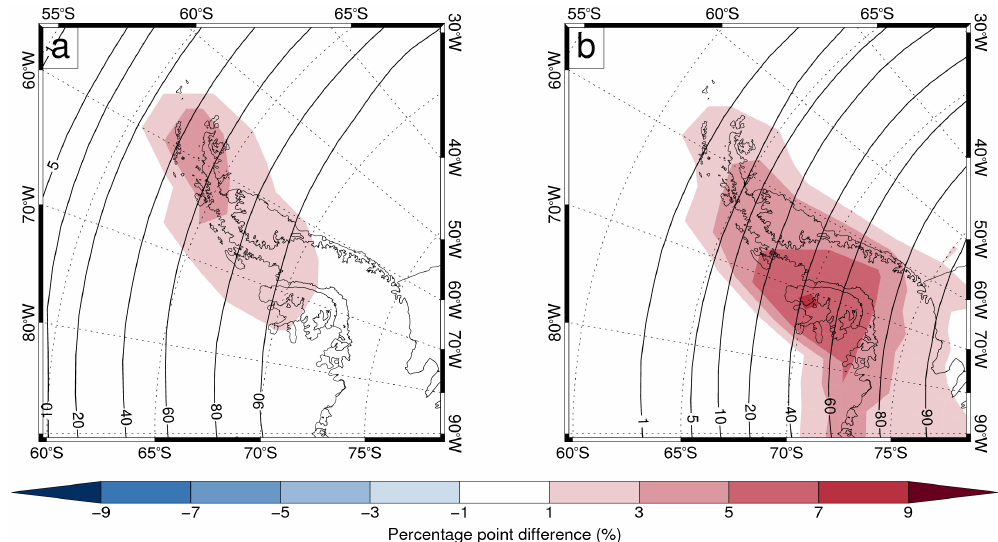
Figure 9. Impact of the mountain wave parameterisation during July at 21km on the frequency f the 195K (a) and 188K (b) temperature thresholds are exceeded over the AP in the perturbation run of the chemistry–climate model. Shown are the 30-year average percentage point differences between the frequency based on the explicitly resolved temperature T CHEM − CLIM plus the parameterised temperature − f T fluctuations (cid:49)T − and the frequency based solely on T CHEM − CLIM , i.e. f . In the perturbed run, (cid:49)T SSO T CHEM − CLIM + (cid:49)T − SSO CHEM − CLIM SSO is represented by the cooling-phase (cid:49)T − only. The temperature thresholds of 195 and 188K are assumed to be representative of the SSO formation of type Ia and II PSCs, respectively. Both differences are computed from 6-hourly fields. The contours indicate the 30-year average frequency f T . Also shown is the coastline of the CHEM − CLIM